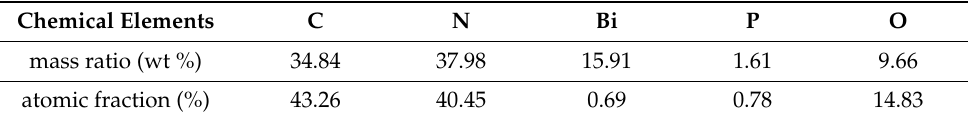
Table 1. Elemental composition of CDBPC